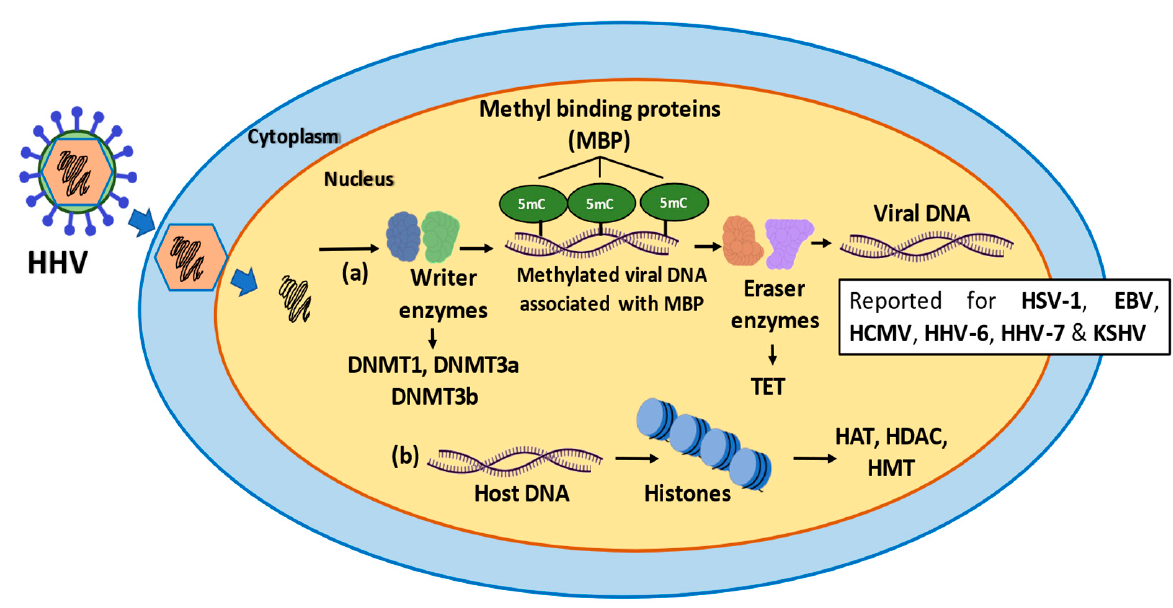
Figure 2. Schematic representation of the epigenetic modifications occurring in viral and host DNA during infection with herpesviruses. (a) Writer enzymes, such as DNMT1, DNMT3a, DNMT3b perform methylations in the viral DNA known as 5’methyl-cytosine (5mC) using SAM as a substrate. The methylation of the DNA is associated with methyl binding proteins (MBP), a type of reader protein, acting as a “scaffold” between 5mC and repressor of complexes such as CoREST. Next, the eraser enzymes (TET) can erase the methylation and form intermediates that are ultimately converted to cytosine such as 5’-hydroxy-methyl-cytosine (5hmC). (b) The histones can also suffer epi- genetic modifications by enzymes such as HAT, HDAC and HMT, that favor the latency phase, depending on the modification. Acetylation of lysine 27 in histone 3 (H3K27ac), is associated with active promoters and enhancers. H4K20ac is associated with gene repression. Methylation of lysine 27 in histone 3 is associated with transcriptional repression. H3K4me is related to transcriptional activity of genes.